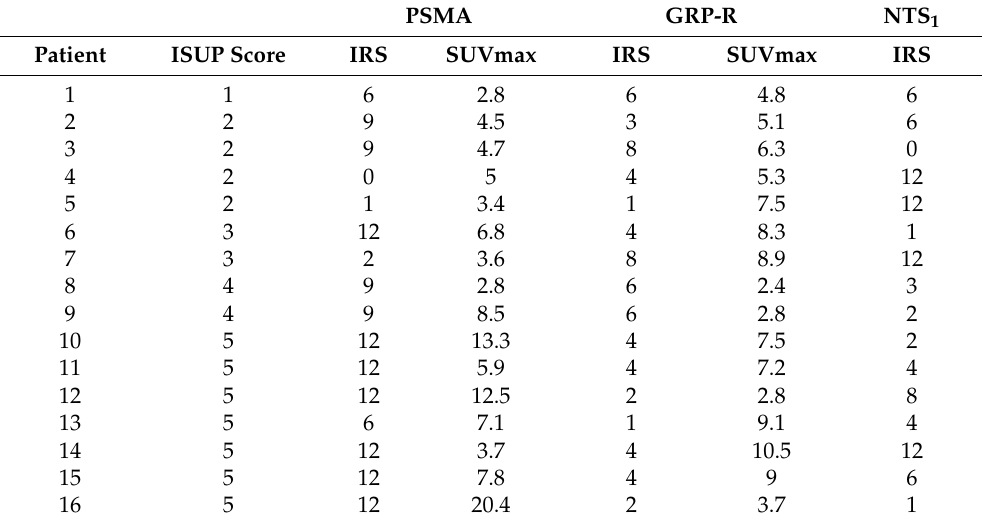
Table 1. PSMA, GRP-R and NTS 1 immunochemistry staining with IRS score according to uptake intensity (Standard Uptake Value—SUVmax) of [ 68 Ga]Ga-PSMA-617 and [ 68 Ga]Ga-RM2 Positron Emission Tomography (PET) imaging. PSMA GRP-R NTS 1 Patient ISUP Score IRS SUVmax